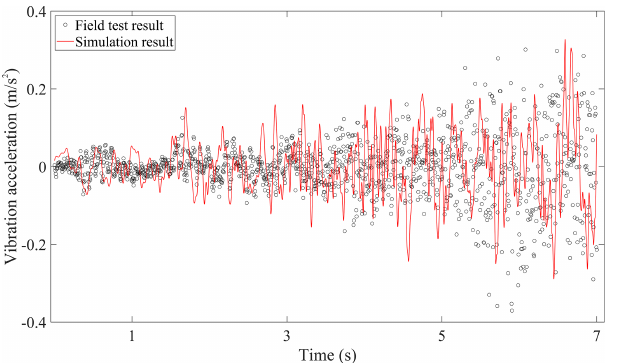
Figure 6. Comparison of vertical vibration responses of the bogie